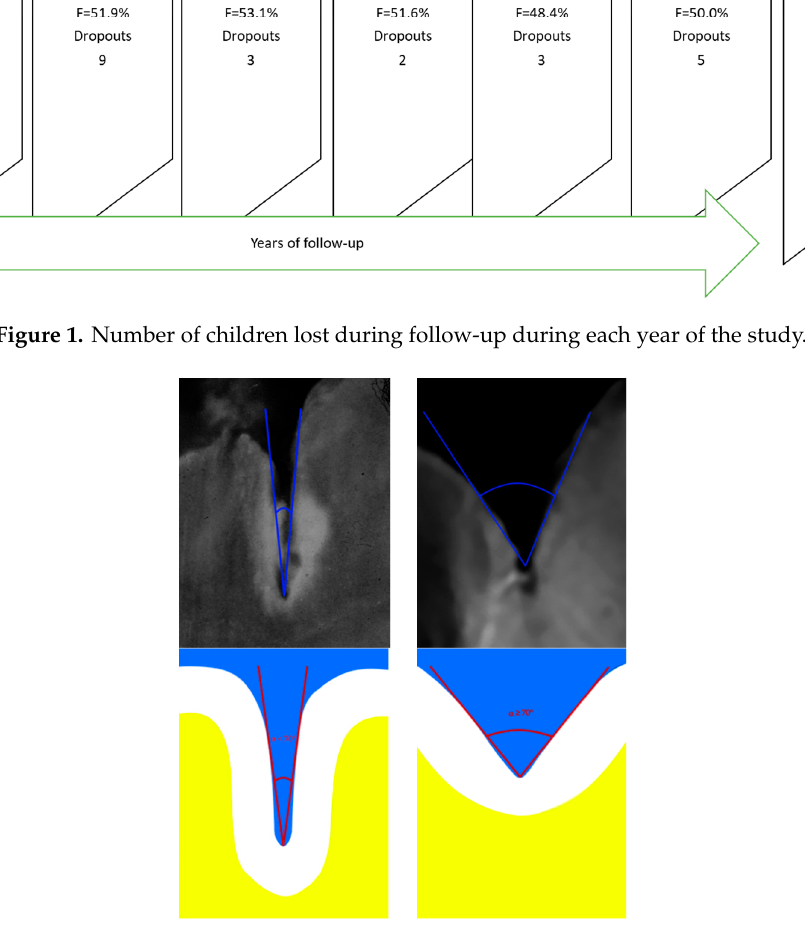
Figure 2. Shallow and deep fissures. Less than 70° “V angle” indicates deep fissure and a wider than 70° “V angle” a shallow fissure.